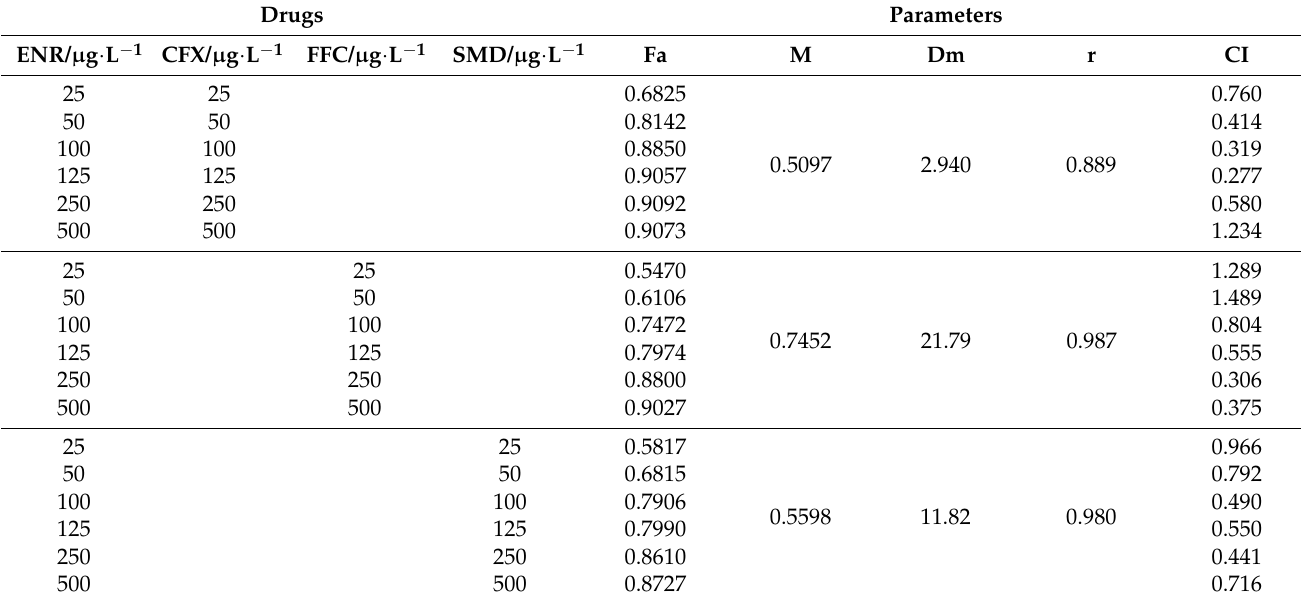
Table 3. CI values and parameters of median-effect plots of binary drug combinations (mixed at 1:1) against THLE-2 cells after 72 h